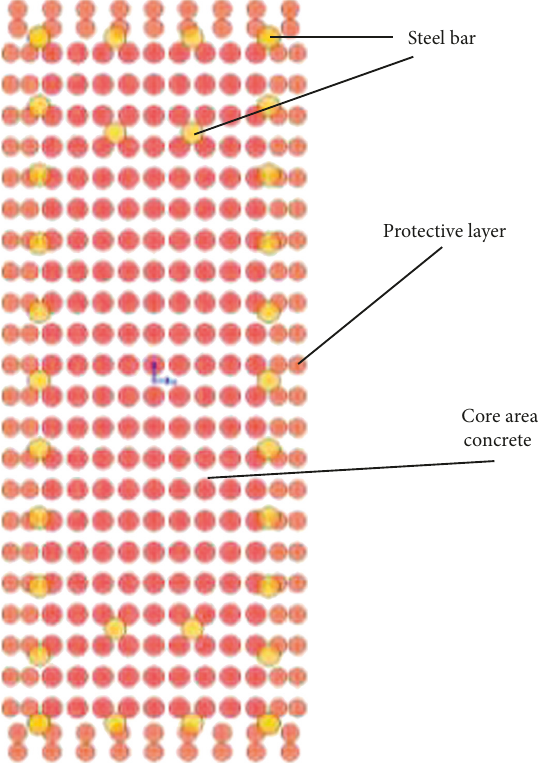
Figure 5: Schematics of fiber cross section.